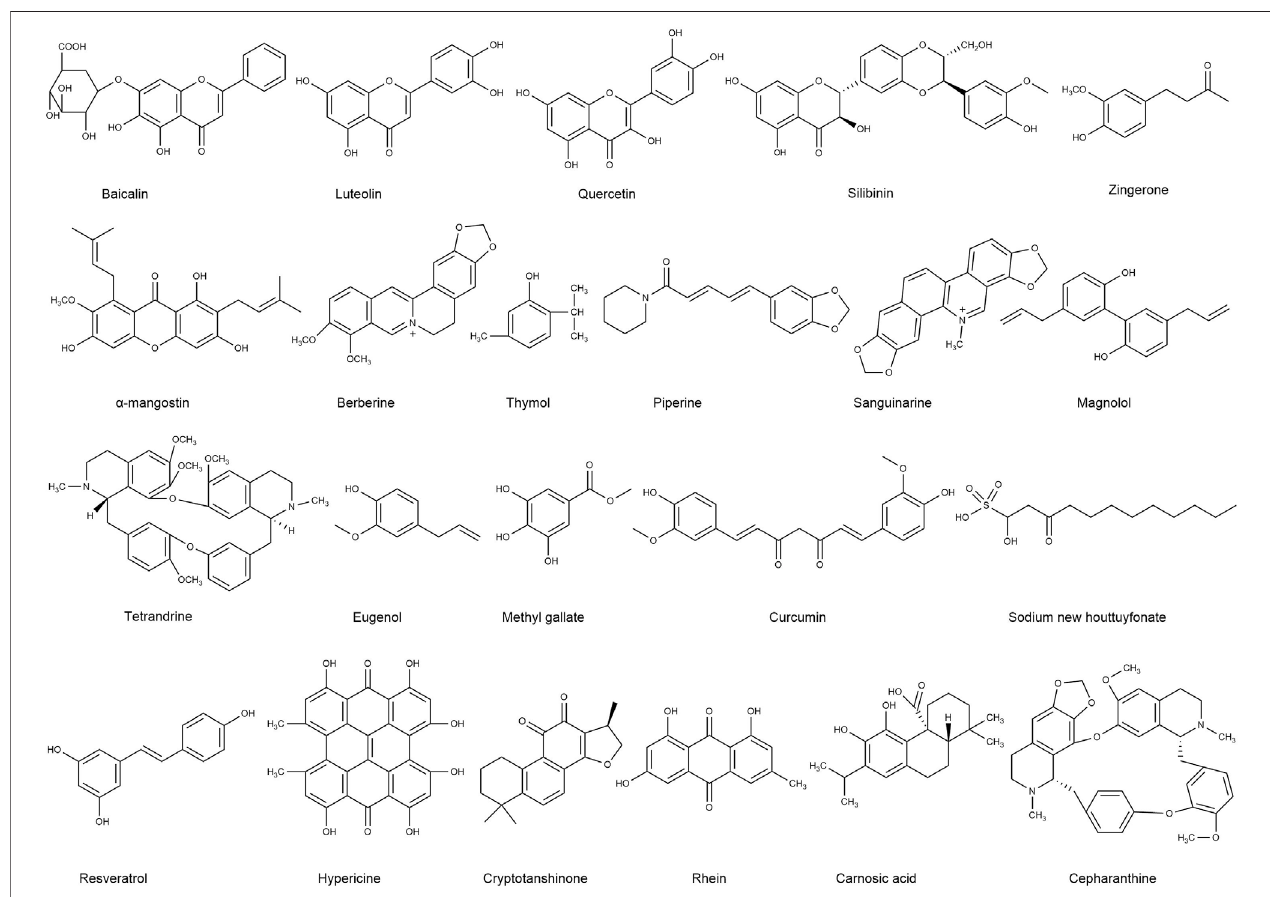
FIGURE 1 | List of key compounds studied for their synergy with